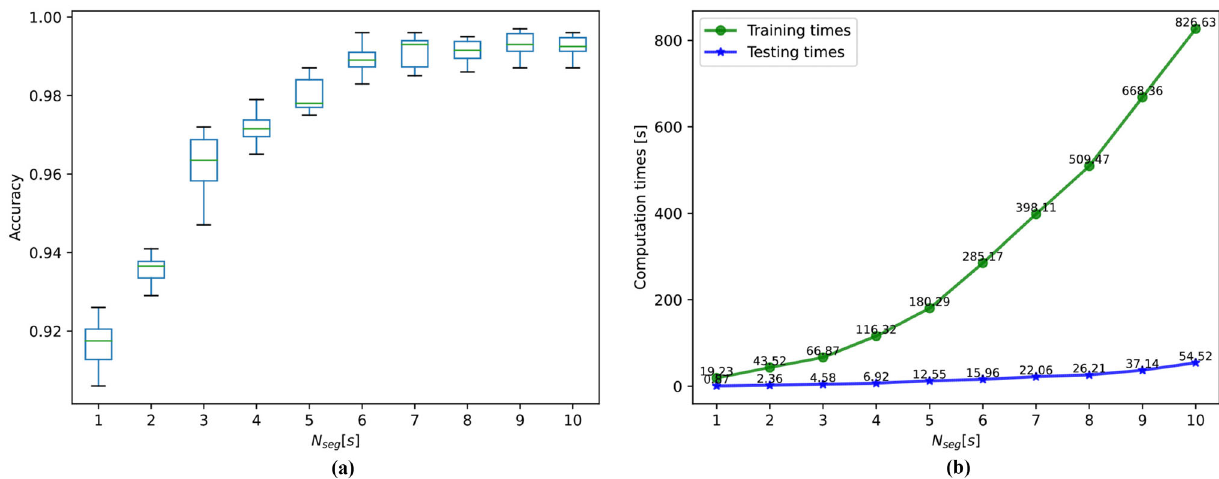
Fig.11 The relationship between segment length and classification accuracy and computation time. a The relationship between the segments length and the accuracy. b The relationship between the segment length and the training and testing times